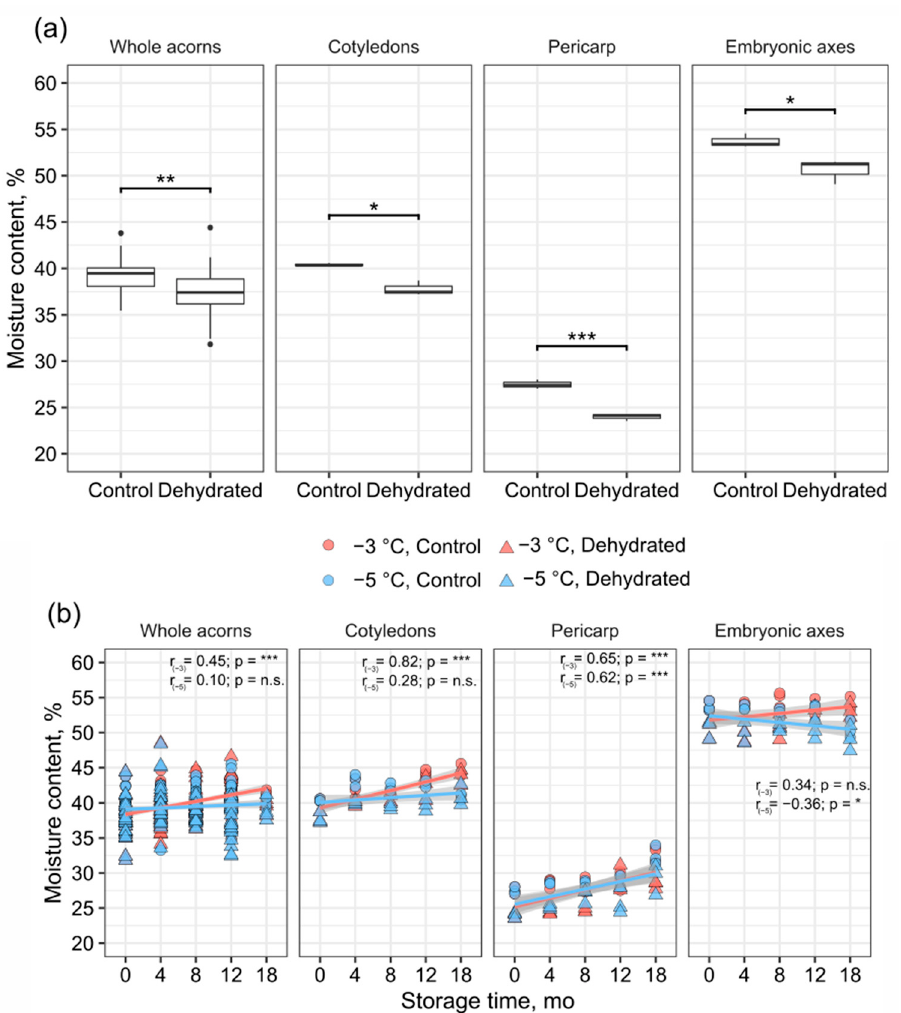
Figure 1. Moisture content (MC) of pedunculate oak acorns. Initial MC ( a ) and changes in MC during 18 mo of storage at − 3 °C or − 5 °C ( b ) are shown for whole seeds, cotyledons, pericarps and embryonic axes separately. Significant differences in each MC were evaluated using a t test ( a ). Regression lines with 95% confidence limits and Pearson correlation coefficients are shown in ( b ). *** p < 0.001, ** p < 0.01, * p < 0.05.